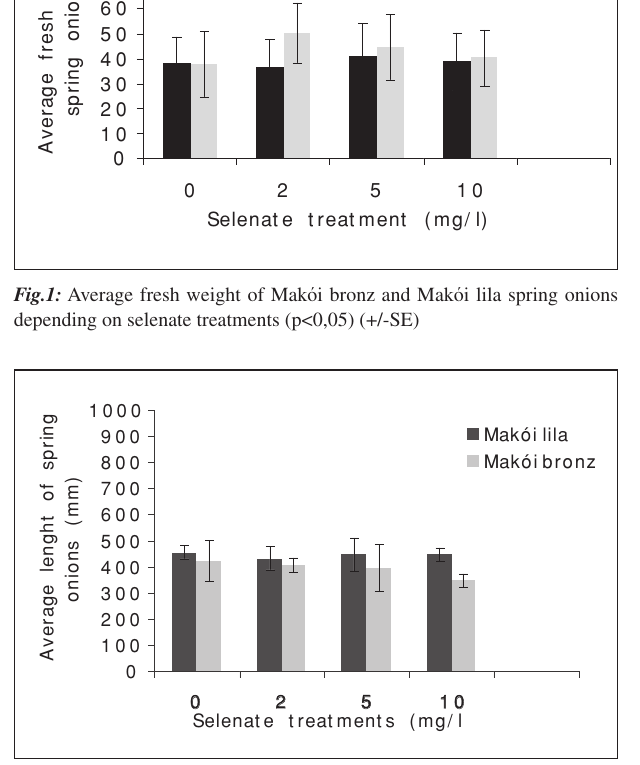
Fig. 2: Average length of Makói bronz and Makói lila spring onions depending on selenate treatment (p<0,05) (+/-SE)